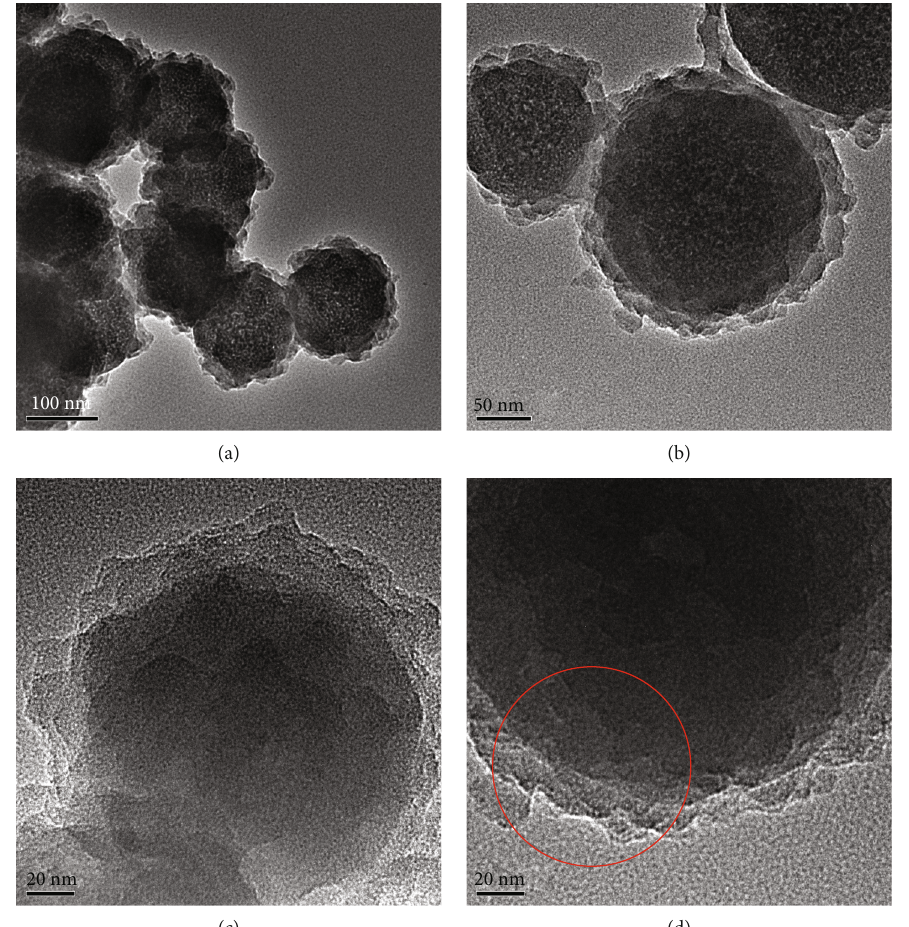
Figure 3: TEM images of (a – d) SiO @PPy NPs in di ff erent magni fi cations. (d) is the close view of (b). (d) The circled part shows the double- 2 layer structure